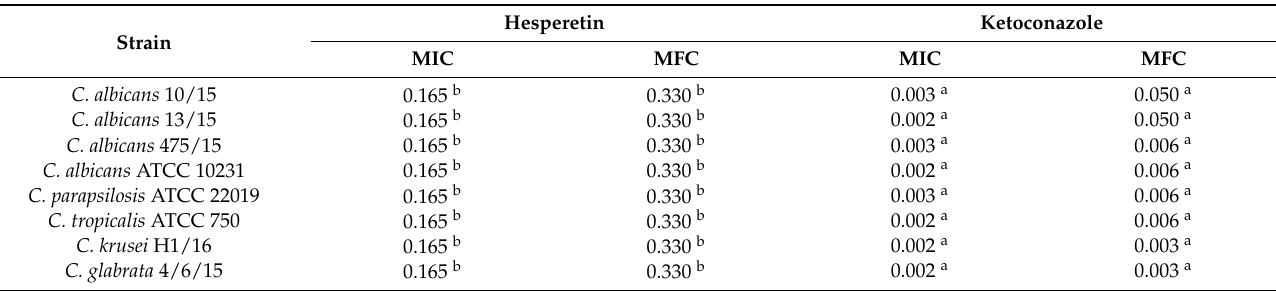
Table 1. Antifungal activity of hesperetin, results are in mg/mL. MIC- minimal inhibitory concentra- tion; MFC- minimal fungicidal concentration. Different letters (a, b) in each row indicate a significant statistical difference between the samples ( p < 0.05). MIC and MFC values are compared separately for each of the fungal strain